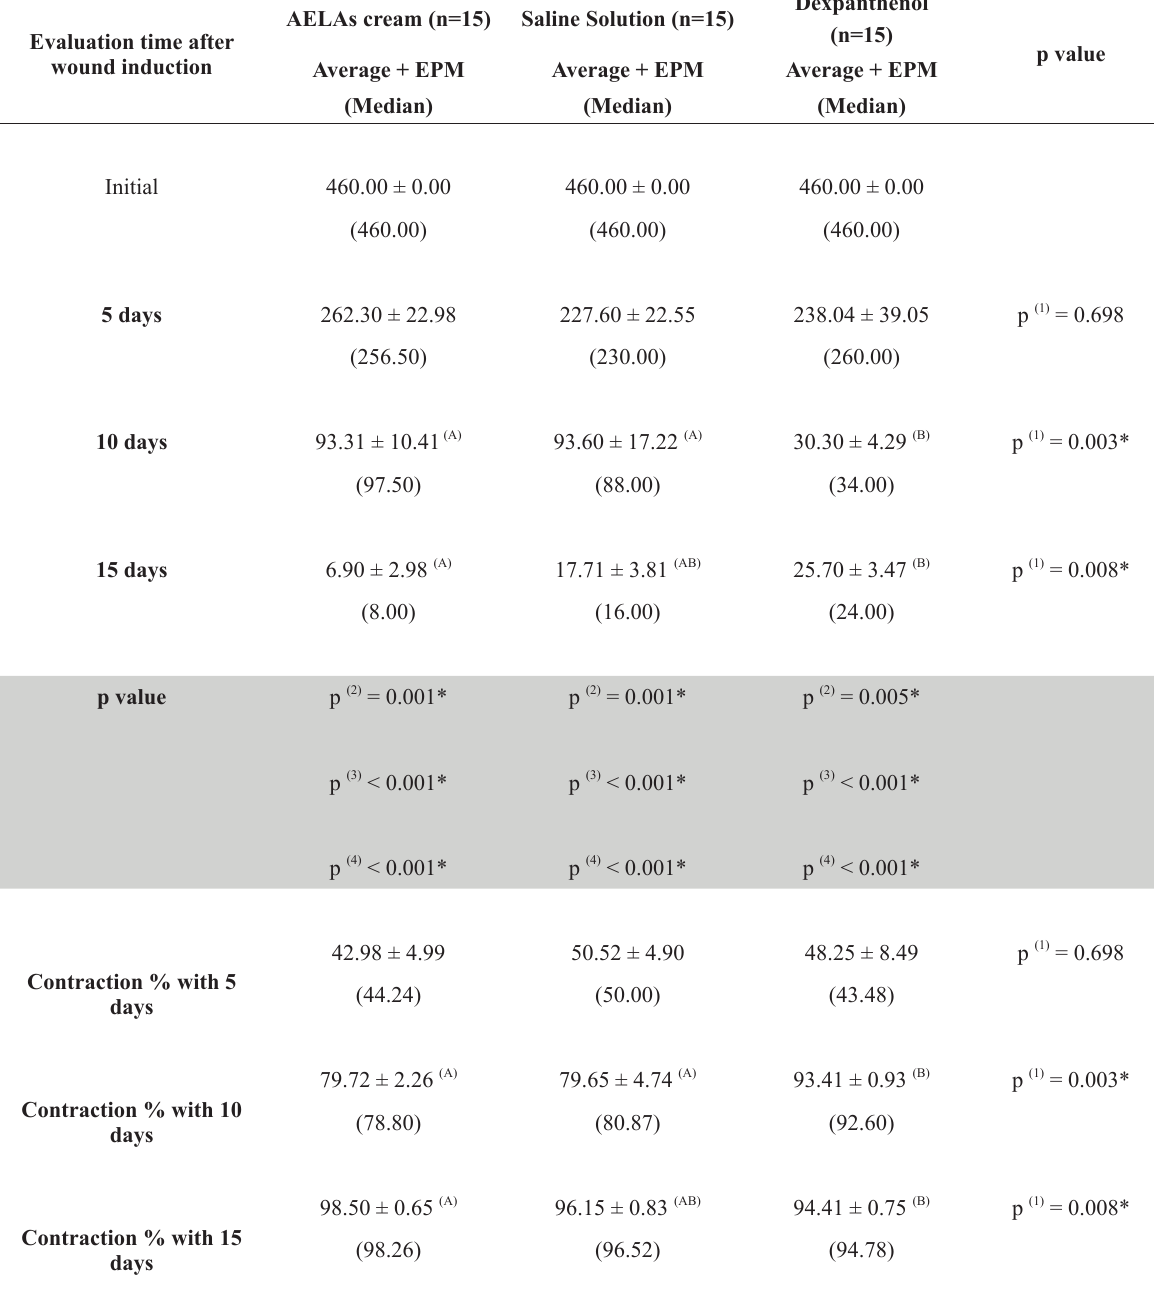
Measurements of wound areas (mm 2 ) and percentage of wound contraction according to the groups and time of evaluation after in vivo surgical procedure